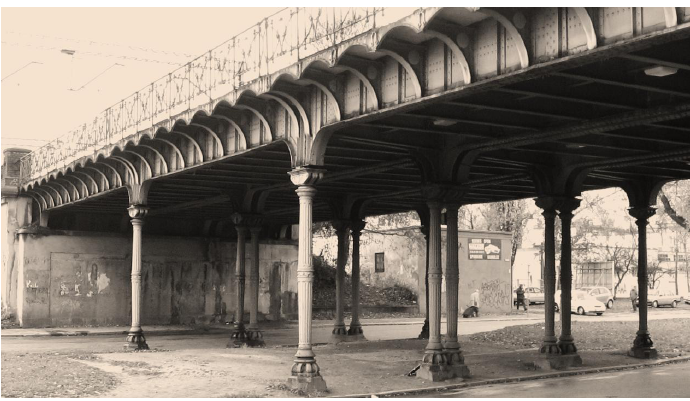
Figure 18. View of the rail overpass over Zaporoska Street in Wrocław.